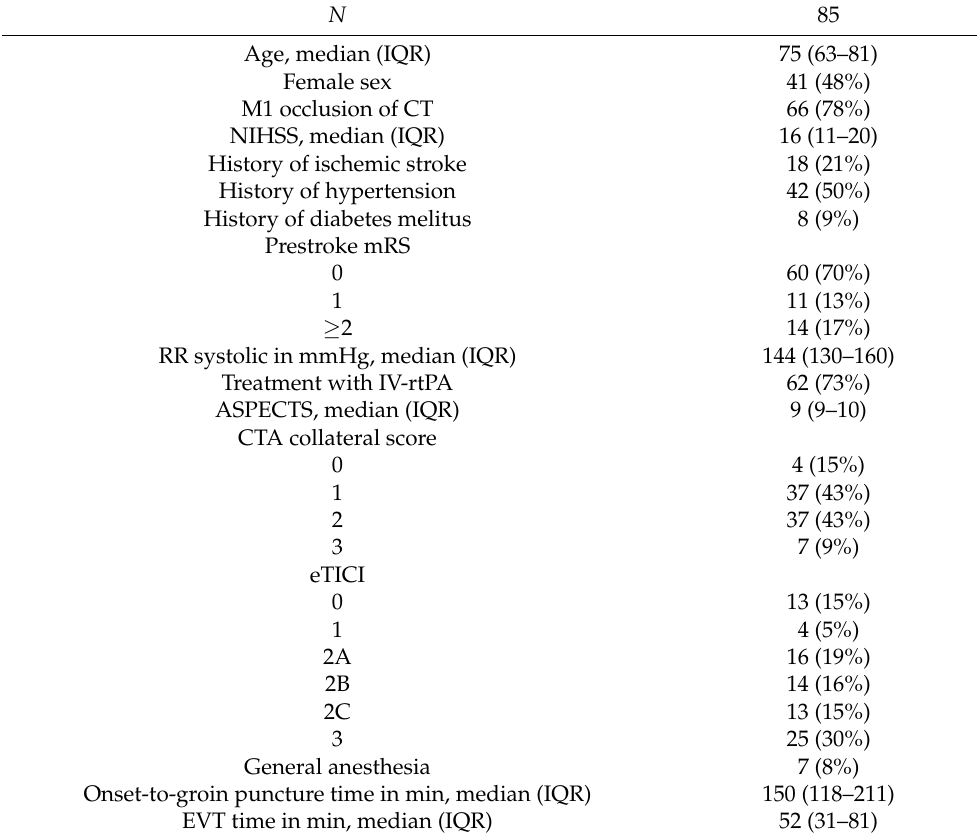
Table 1. Baseline